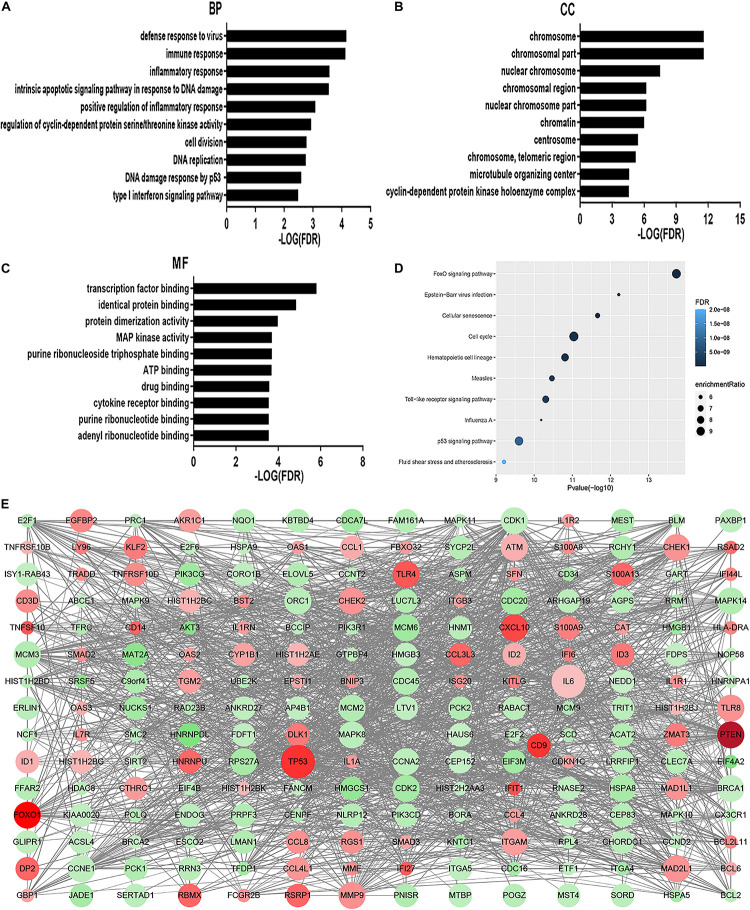
GO analysis and KEGG analysis. Results of BP (A), CC (B), and MF (C) in GO analysis revealed the relationship between hub genes and functional pathways. Top 10 pathway enrichment was shown by bubble chart (D) in KEGG analysis. The FDR < 0.05 was considered as significance. BP, biological process; CC, cellular component; MF, molecular function; KEGG, Kyoto Encyclopedia of Genes and Genomes. DEGs PPI network was constructed containing 256 DEGs based on the STRING online database (89 upregulated DEGs labeled in red and 167 downregulated DEGs labeled in green). The size of dots represents the node degree (E).